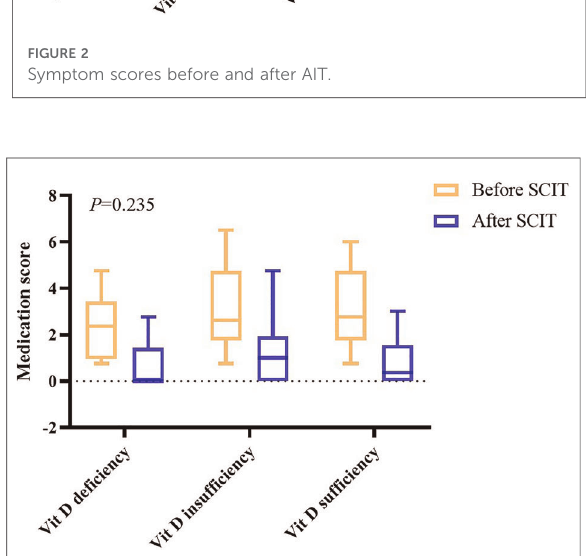
FIGURE 2 Symptom scores before and after AIT.